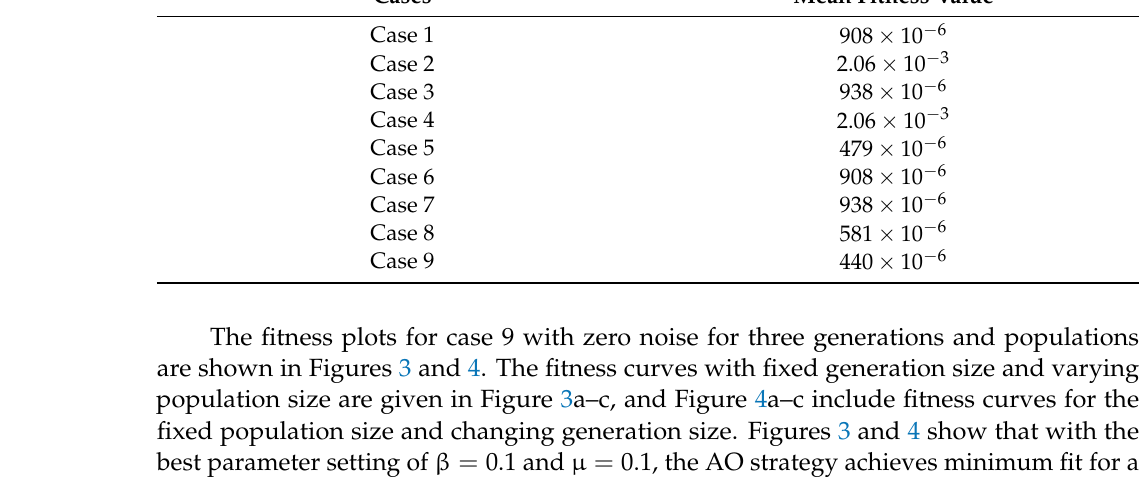
Apart from the fitness results presented in Tables 2–10, the mean fit values achieved with nine ( β and μ ) variations, three generations, and three populations are presented in Table 11. It is observed from the mean fit values in Table 11 that AO obtained the minimum mean fit for case 9, i.e., 440 × 10 (cid:2879)(cid:2874) . Therefore, for optimal AO performance, the remaining simulation results are presented with the best hyper-parameter values, i.e., β = 0.1 and μ = 0.1 . Table 11. AO parameter tuning mean value analysis. Table 11. AO parameter tuning mean value analysis.